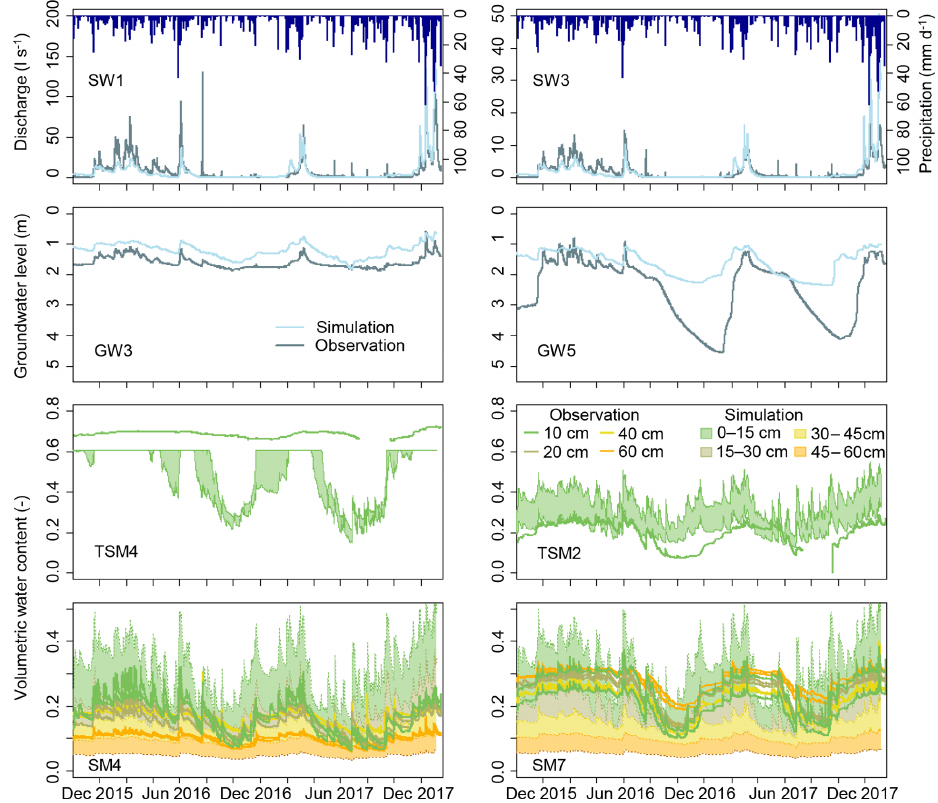
Figure 3. Simulated and observed time series of discharge, groundwater levels below the surface, and volumetric water content. Colour bands indicate the possible span of simulated volumetric water contents in between two model nodes. The time series for the observation locations (cf. Fig. 1) that are not shown here are shown in the Supplement (Fig. S1). Table 2. Pearson correlation coefficients for the relation between simulated and observed dynamics of volumetric water content of the soil for the different measurement locations and depths (cf. Fig.